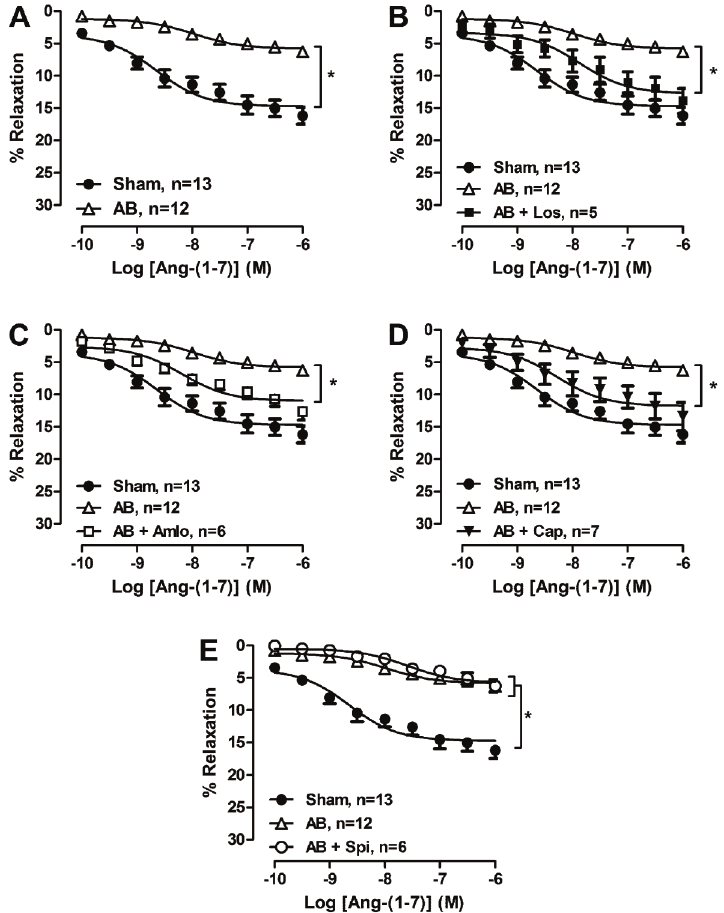
Figure 1. A , Effect of Ang-(1-7) on the vasore- laxation in aortic rings from rats that